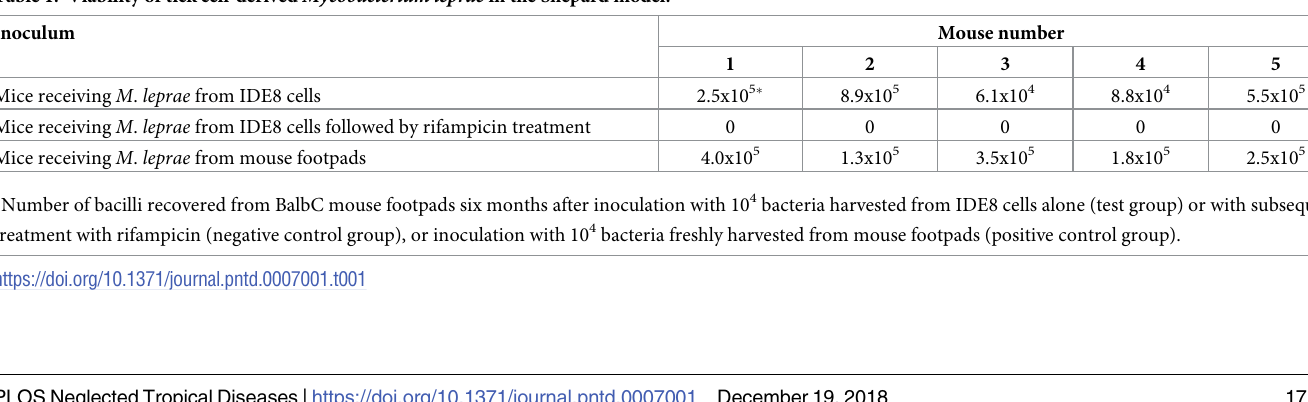
Fig 7. Mycobacterium leprae is able to grow in tick cell cultures. Tick cell lines AVL/CTVM17, HAE/CTVM8 and IDE8 were infected with M . leprae ; the initial inoculum (24h) and the bacillary load after 10 and 20 days of incubation at 30˚C were determined by cell lysis and counting of total acid-fast bacilli. In (A) AVL/CTVM17 and (B) HAE/ CTVM8 cells there was a slight, non-significant increase in bacteria over the first 10 days followed by a decrease, whereas in (C) IDE8 cells there was a significant increase in bacterial numbers over the 20-day period. Each bar represents the mean of nine independent cultures performed using three different M . leprae preparations. (D) Viable M . leprae titer in human monocyte THP-1 cells and tick cell lines after 20 days of infection. Levels of 16S rRNA (viable bacillus marker) and 16S rDNA ( M . leprae genome normalizer) were determined by qPCR. Through generation of qPCR standard curves by titration of known numbers of live M . leprae bacilli in different cell cultures, values were converted into number of genomes (viable M . leprae , y-axis). Combined results from three independent experiments, in which none of the negative control samples showed detectable signal; �� = p < 0.0001 by Dunn’s multiple comparisons test.